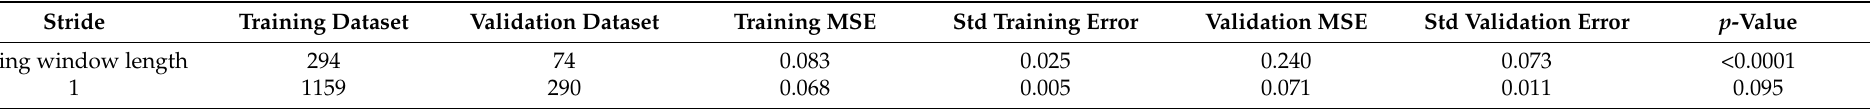
Table 6. Evaluation of training and validation MSE of 3-layer 3D CAEs trained with calendered and uncalendered mini microstructures.